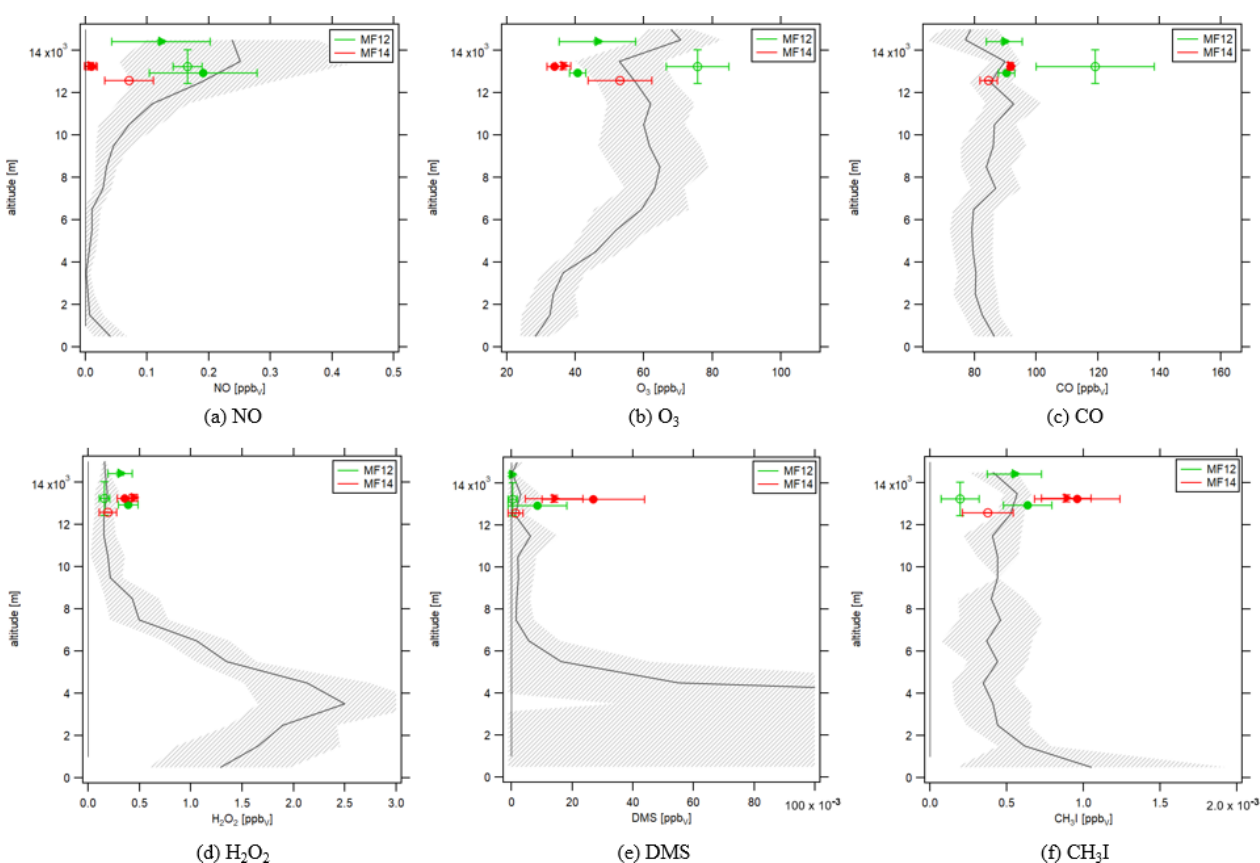
Figure 4. Vertical profiles of the background trace gas concentrations during CAFE Africa around Cabo Verde (gray) and the average trace gas concentrations for convective (filled symbols) and non-convective (open symbols) areas during MF12 (green) and MF14